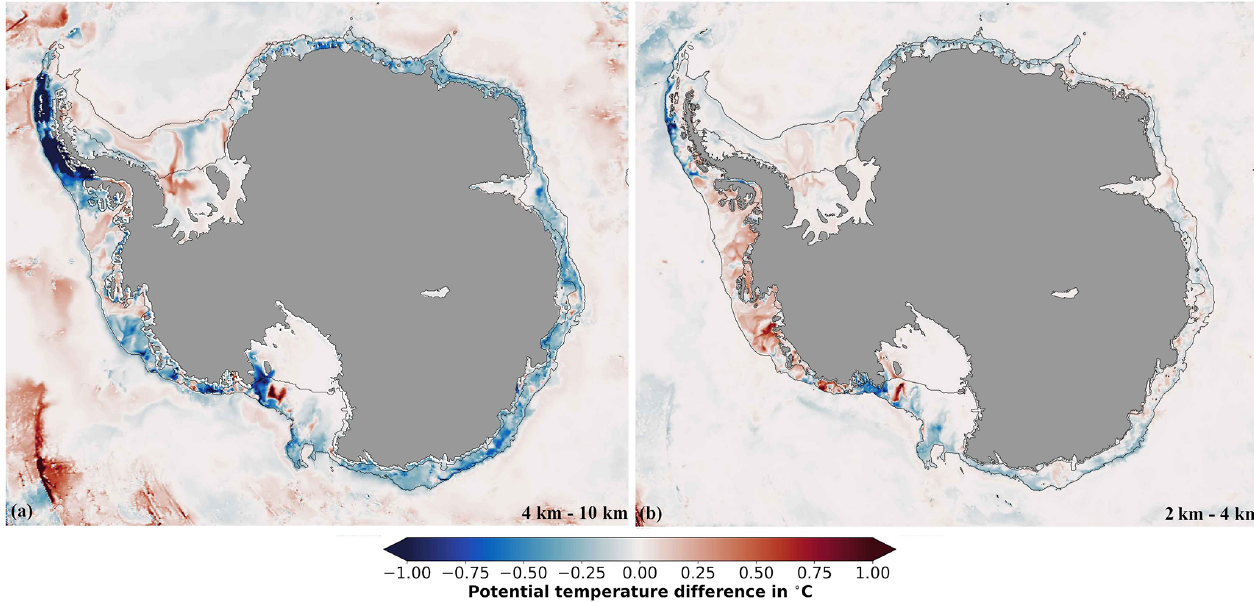
Figure 5. The effect of model resolution on bottom layer temperature. Change in annual average bottom sigma layer potential temperature when increasing the horizontal model resolution from (a) 10 to 4km and (b) 4 to 2km. Black contour lines indicate the 1500m isobath and ice shelf